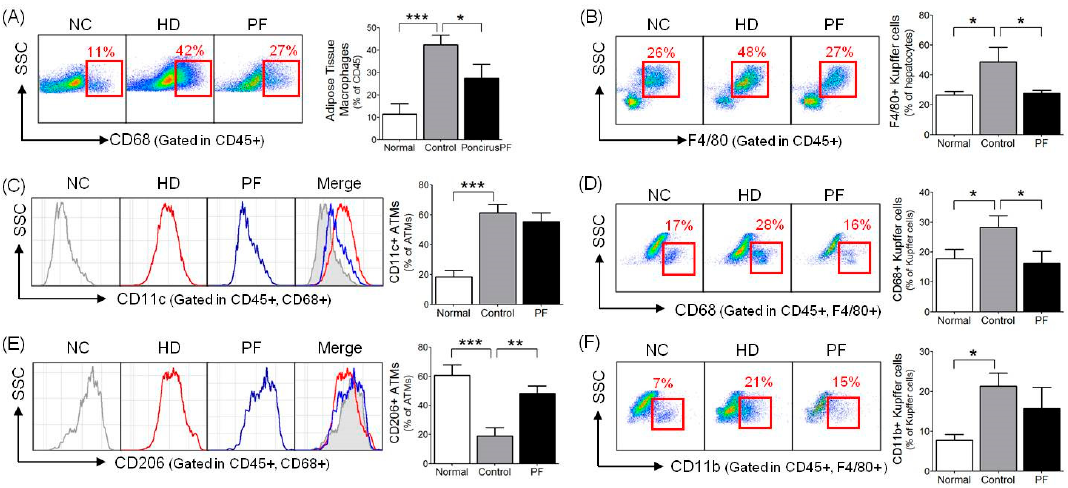
Figure 4. Effect of PF on adipose tissue macrophage (ATM) infiltration rate in ( A ) CD68 + , ( C ) CD11c + , and ( E ) CD206 + cells and Kupffer cell infiltration rate in ( B ) F4/80 + , ( D ) CD68 + , and ( F ) CD11b + cells. n = 6 in each group. Data shown are the mean ± SEM. * p < 0.05, ** p < 0.01, *** p < 0.001, compared with HFD.